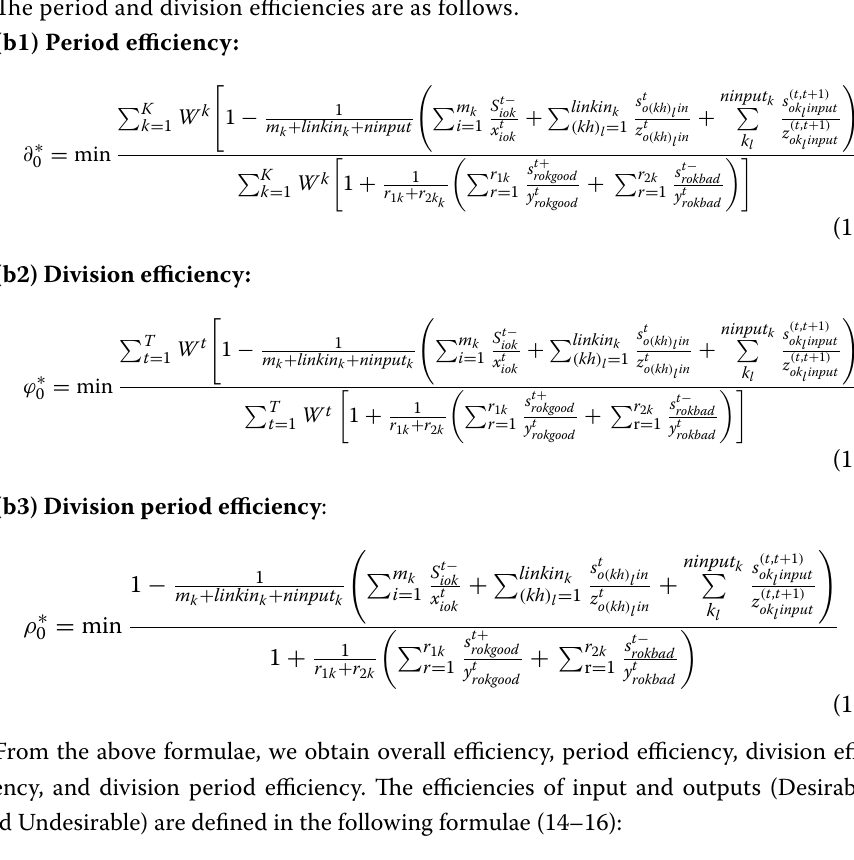
Actual input Target input = Target Undesirable output Actual Undesirable =